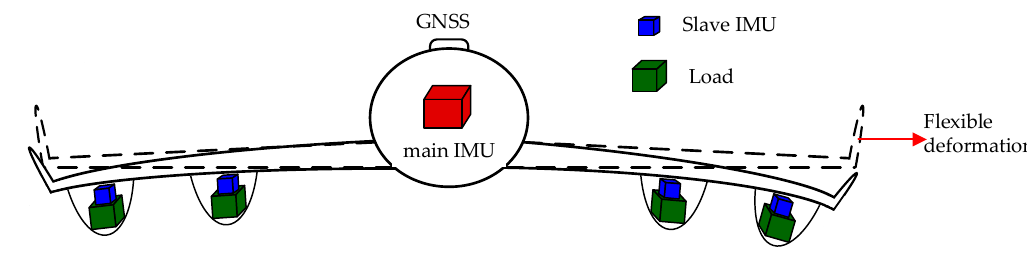
Figure 1. Flexural deformation diagram.